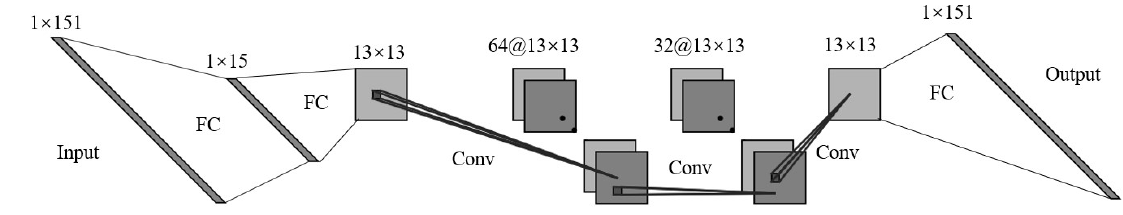
Figure 1. The network architecture of WER-Net.